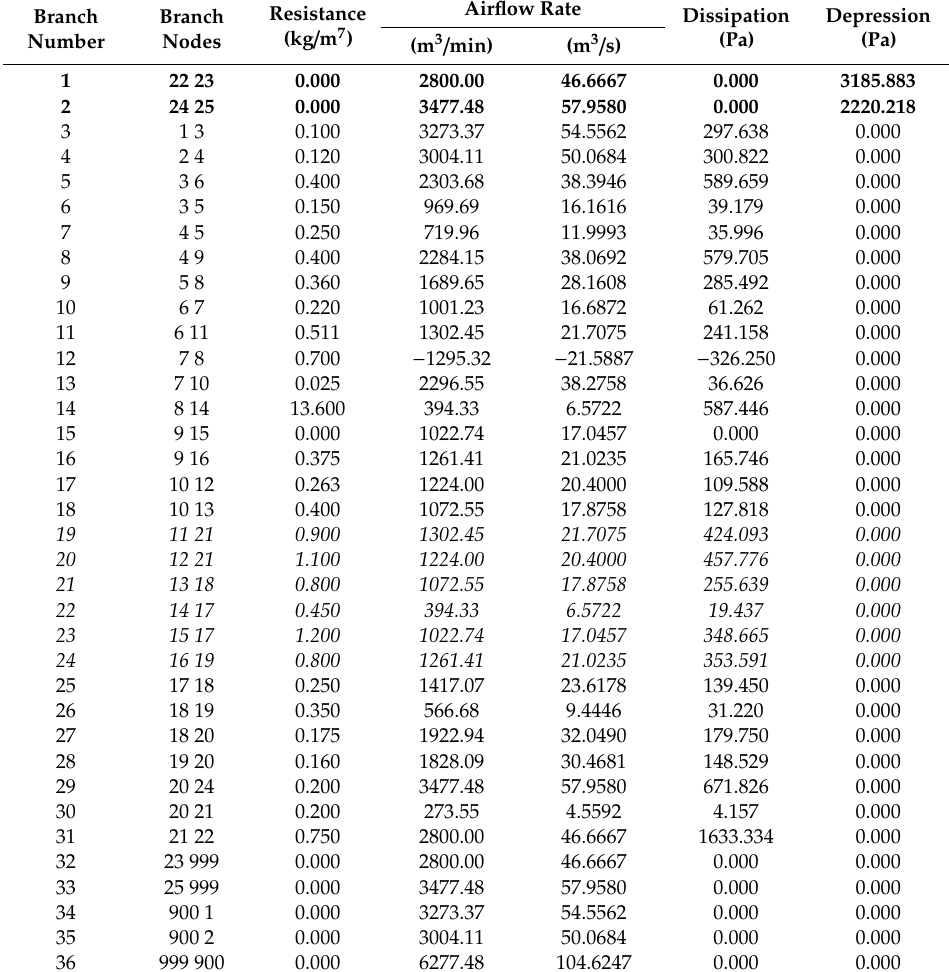
Table 4. Airflow distribution in mine B in the case of reverse ventilation (own